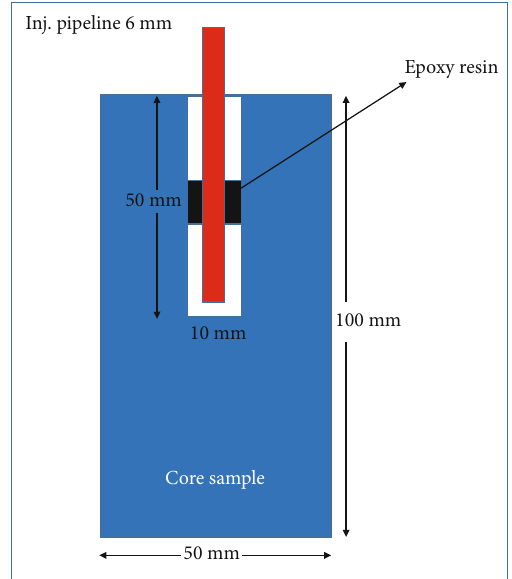
Figure 3: A schematic showing the test sample con fi guration.